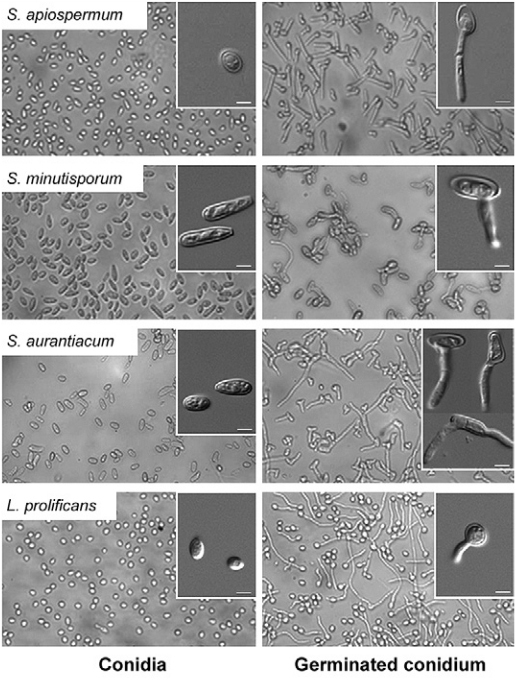
: light microscopies showing the dormant (0 h-conidia) and germinated conidial cells of Scedosporium apiospermum, S. minutisporum, S. aurantiacum and Lomentospora prolificans after 4 h of incubation in Sabouraud medium at 37ºC in an atmosphere of 5% CO2. The insets highlighted the different morphologies regarding both conidia and germinated conidia observed in each studied fungus. Bars represent 4 μm.